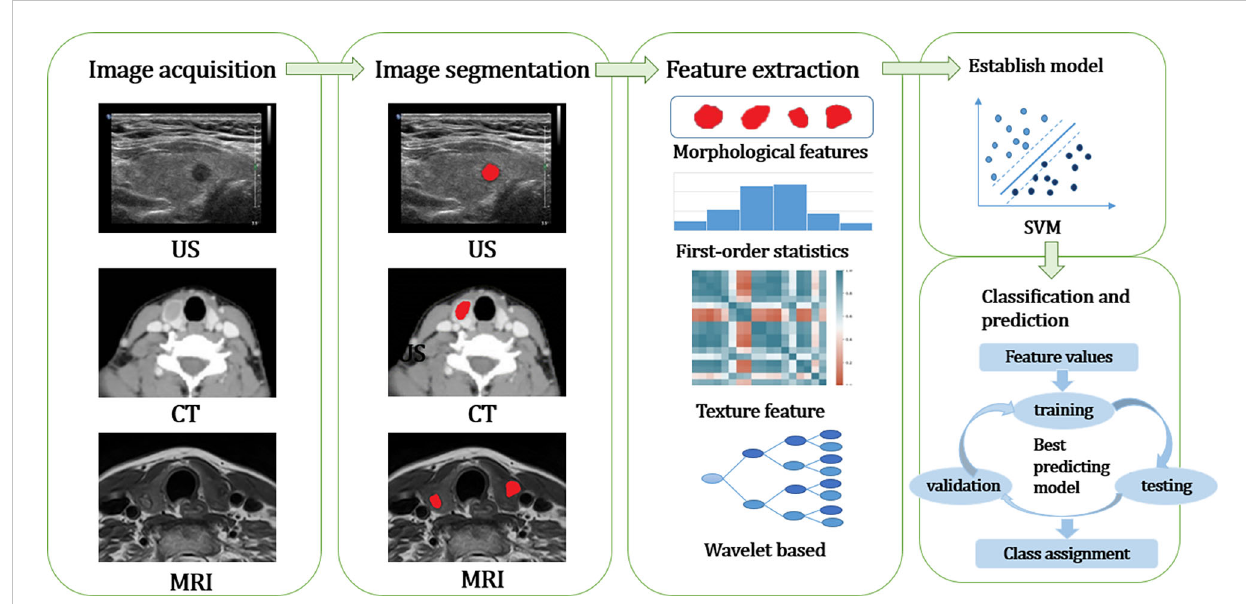
FIGURE 1 The work fl ow of radiomics can be summarized as follows: ① Image acquisition; ② Image segmentation; ③ Feature extraction and Feature selection; ④ Establish models and databases to classify the prediction results. US, ultrasound; CT, computed tomography; MRI, magnetic resonance imaging; SVM, support vector